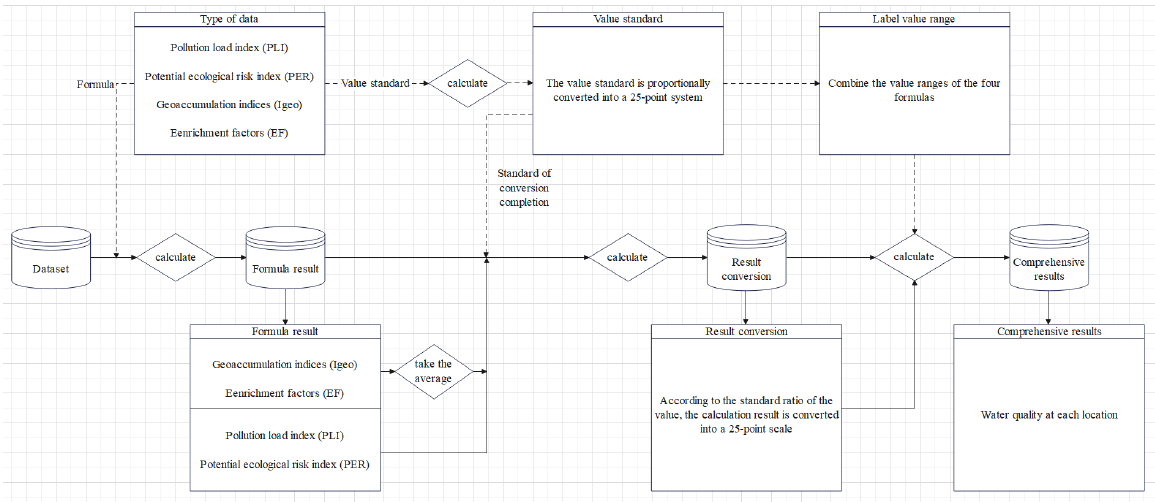
Figure 1. The overall data labelling